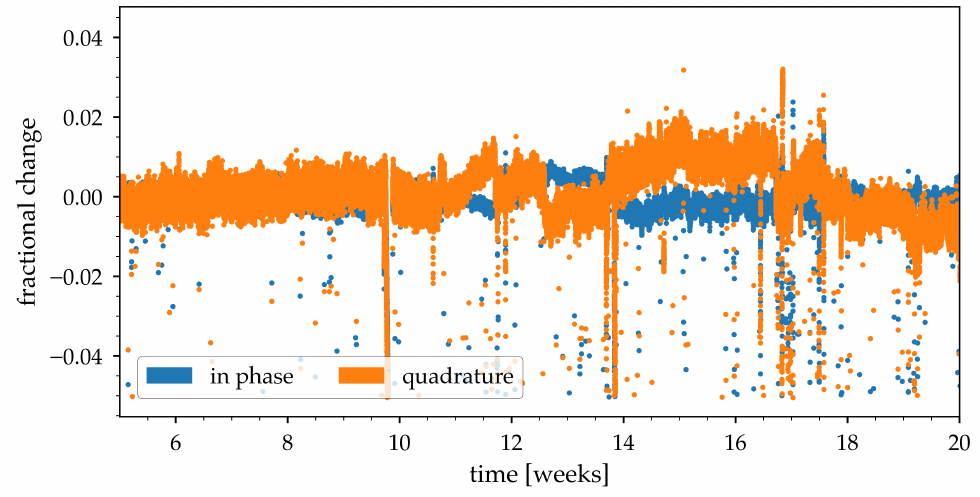
Figure 8. Vector components of the five DTL tanks as a function of time during the study. A running SVD was also performed on the amplitude and phase signals. The SVD was computed in increments of 10 time samples along the period of interest. Because the resulting singular values ranged widely in magnitude, they were scaled using a robust scaler technique. The robust scaler removed the median and scaled the data according to the interquartile range. Centering and scaling happened independently on each feature by computing the relevant statistics on the samples in the data set. This ensured large changes in small singular values would not be washed out by the small changes in large singular values when aggregating. The scaled singular values were added and plotted as a function of time, Figure